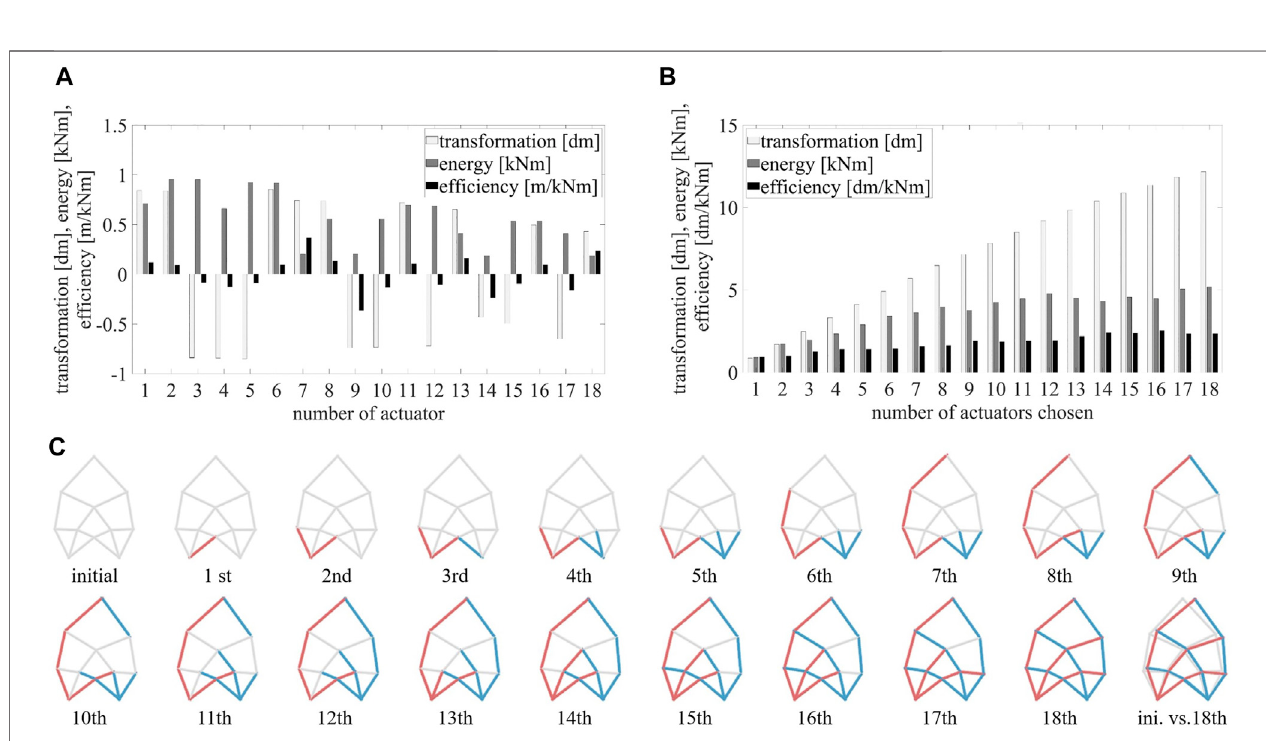
FIGURE 5 | Bar charts of (A) individual actuator placement (corresponding numbers of actuators ( Figure 4D ) and (B) heuristic actuator placement corresponding to (C) stepwise process of choice for the placement of 18 actuators (red: compression, blue: tension actuators) by operator χ .